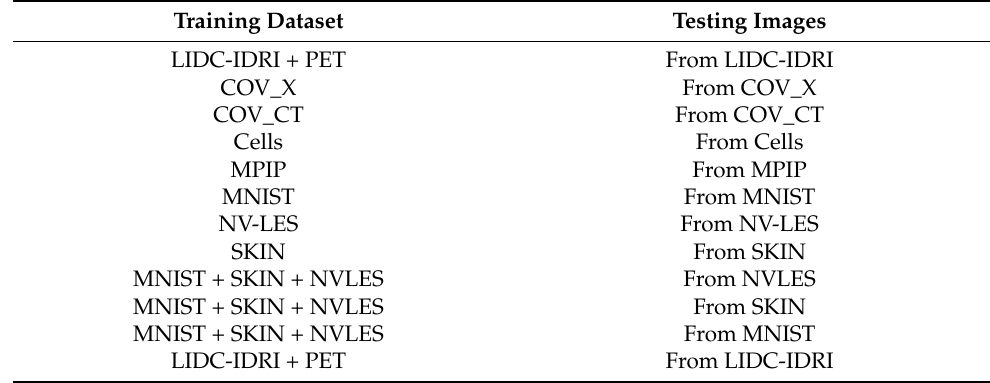
Table 13. The training dataset and the testing image of each visualised Grad-CAM. Training Dataset Testing